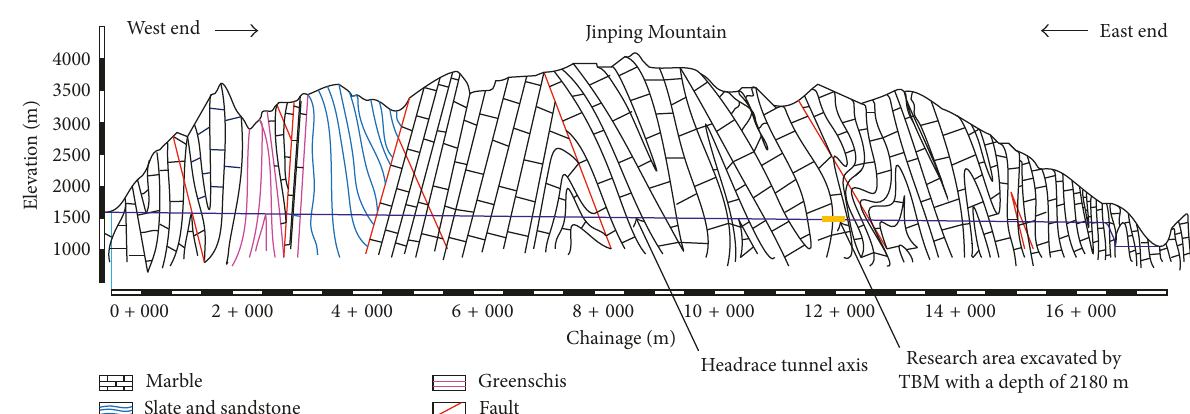
Figure 3: Geomorphic map along the headrace tunnels of the Jinping II hydropower